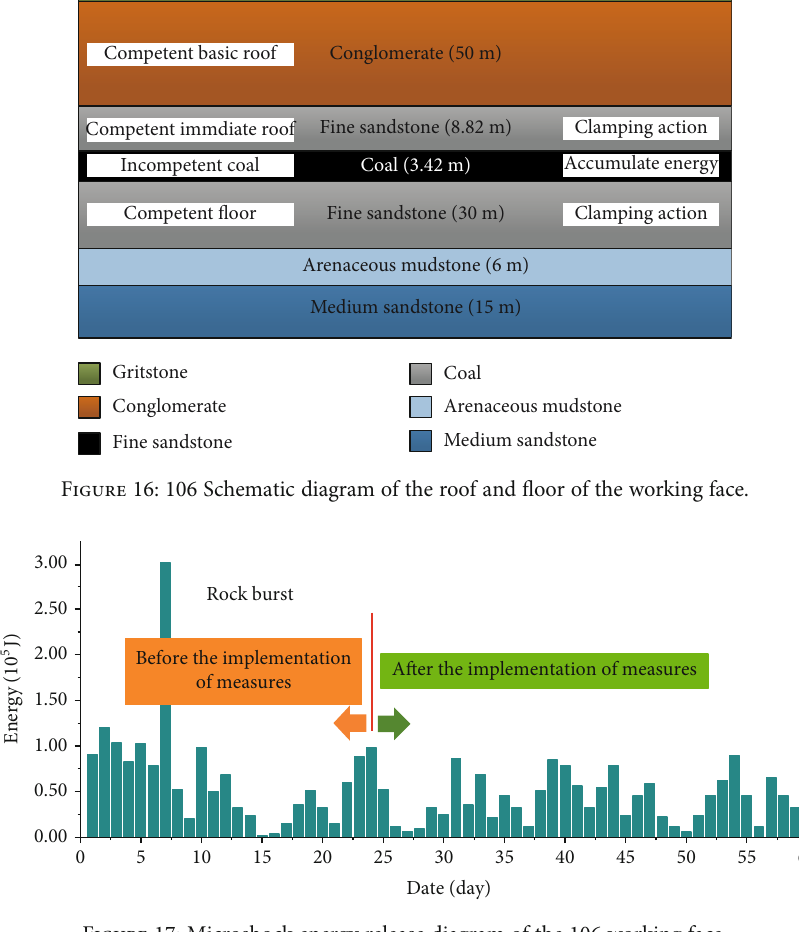
Figure 17: Microshock energy release diagram of the 106 working face.